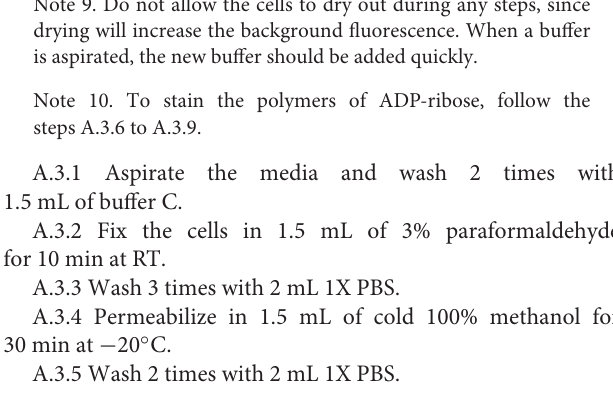
remove the lid of the dish and start the timer simultaneously. After the calculated time, place the lid back to stop